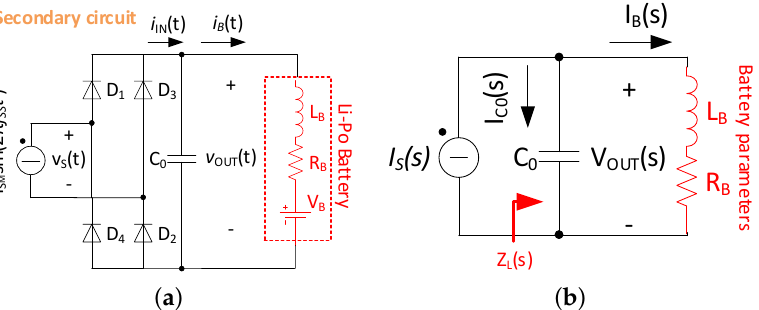
Figure 2. Equivalent circuit under investigation ( a ); current-fed linear circuit studied to extract the load frequency response ( b